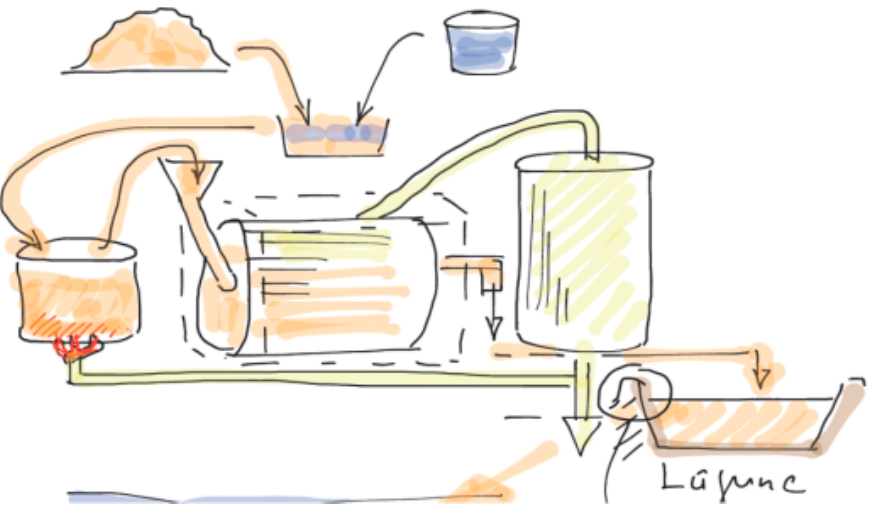
Figure 5. Improved design of the simple liquid manure digester [42].